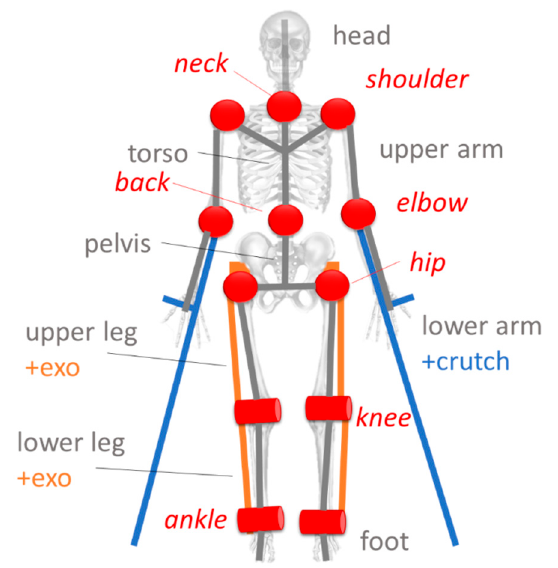
Figure 5. Mechanical model used to interpret the kinematic and dynamic data. Body segments are shown in black. Joints are shown in red. Cylinders indicate cylindrical joints. Balls indicate spherical joints.